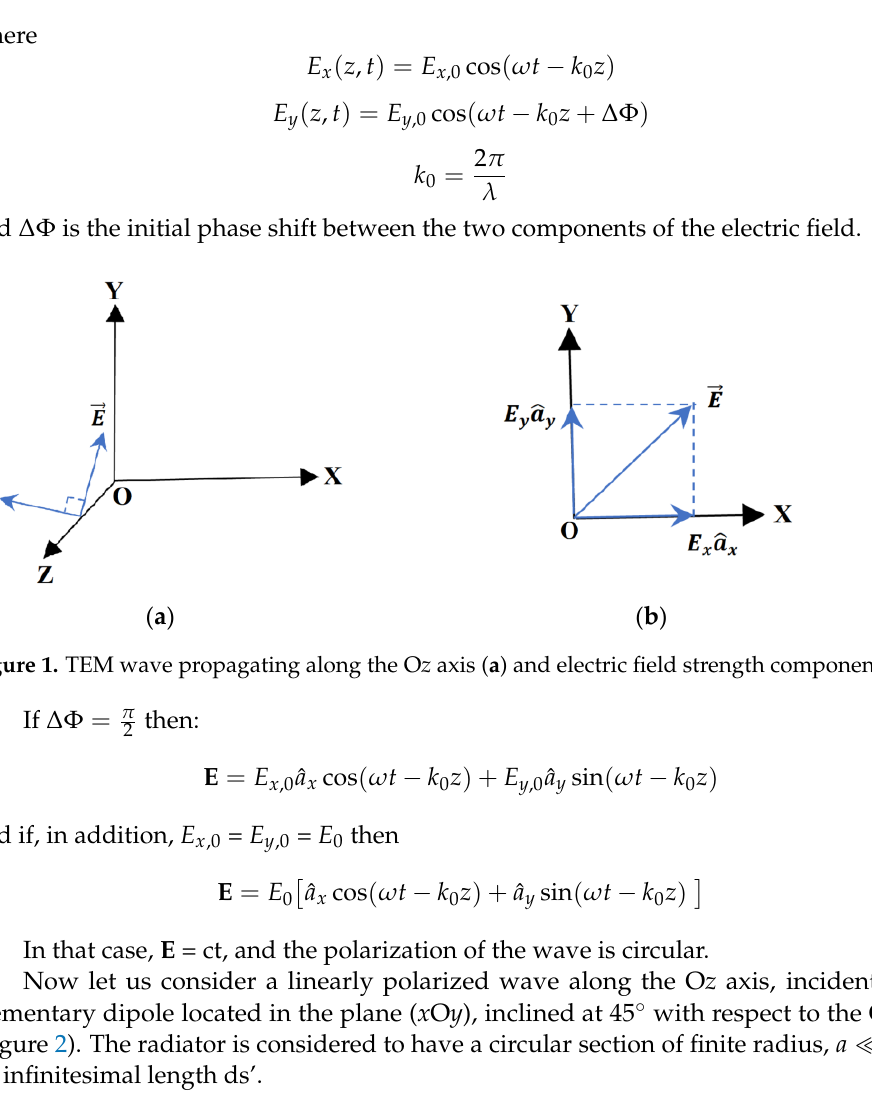
Figure 2. Linearly polarized wave incident to an elementary dipole.